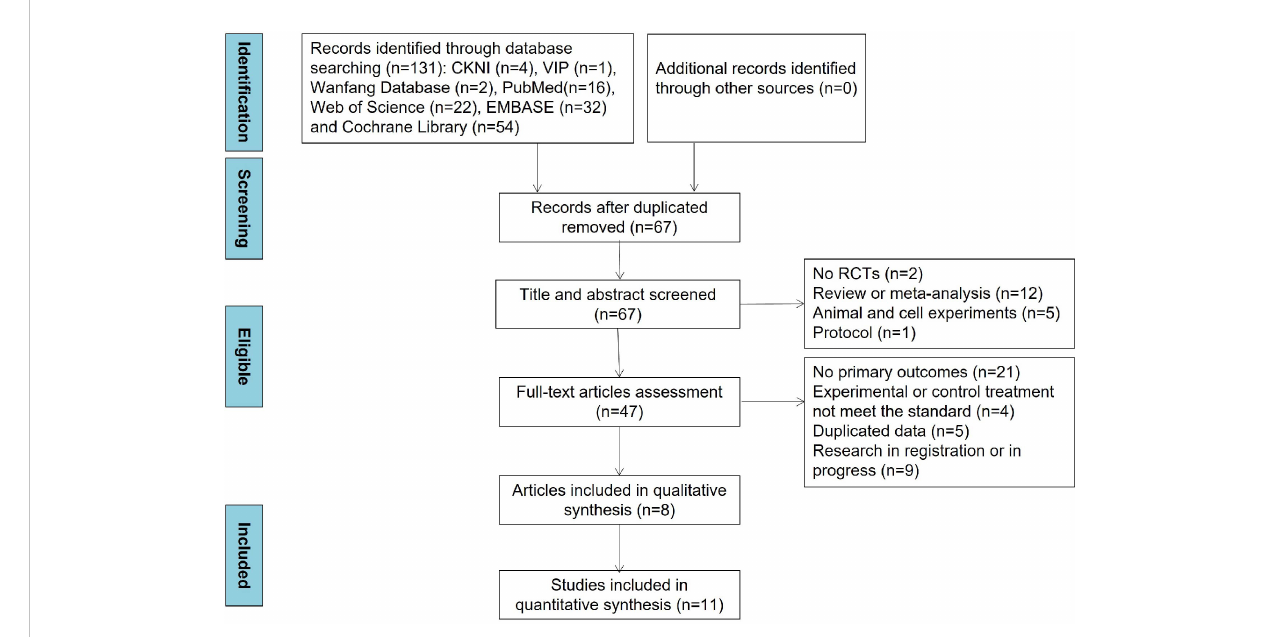
FIGURE 1 Flow diagram of literature